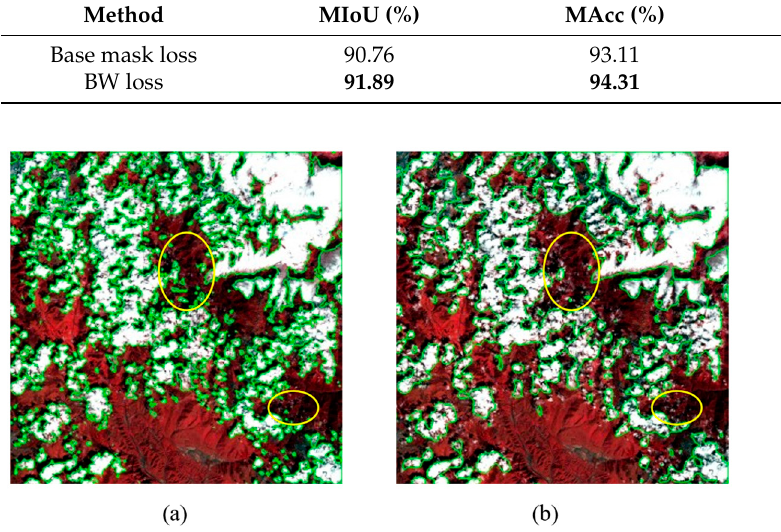
Table 2. Multi-scale Transformer decoder ablation experiment results.